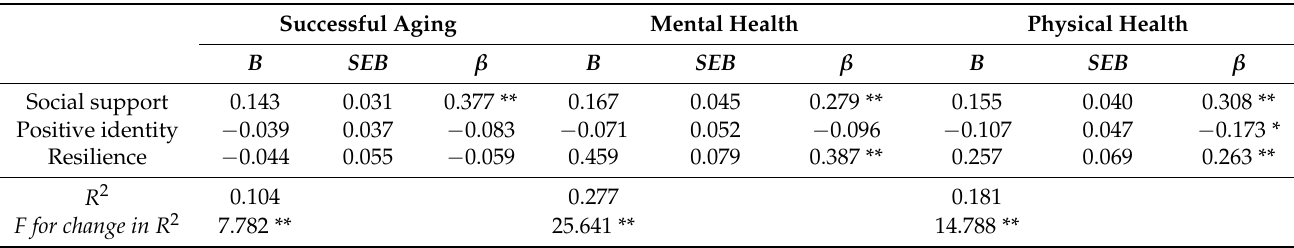
Table 4. Social support, positive identity, and resilience linear regression models predicting success aging, mental health, and physical